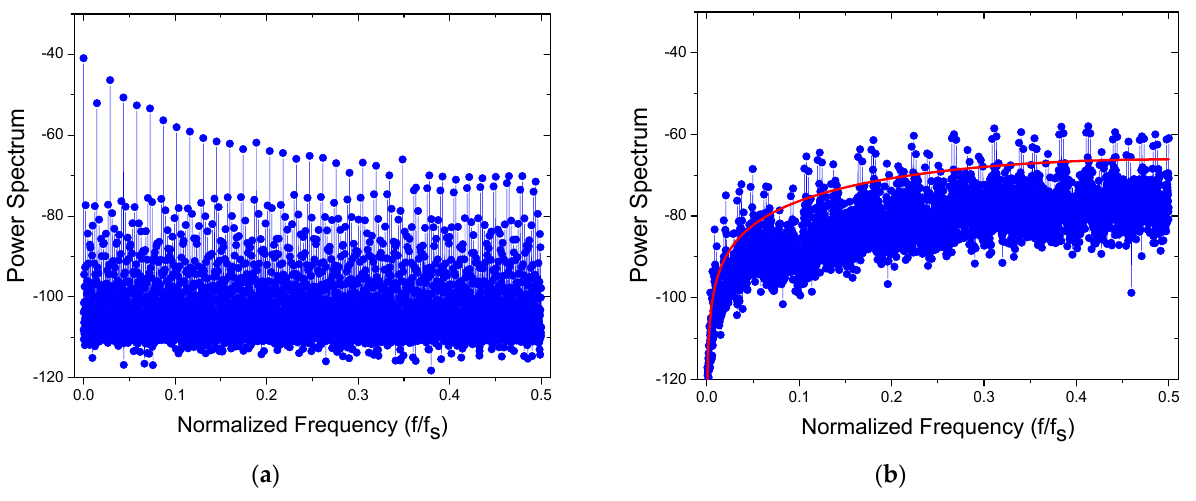
Figure 3. Power spectrum of the error signal from the behavioral simulation of Figure 2. N fft = 8192. Average of 100 iterations. ( a ) Simulations without mismatch error shaping, ( b ) simulations with element rotations.